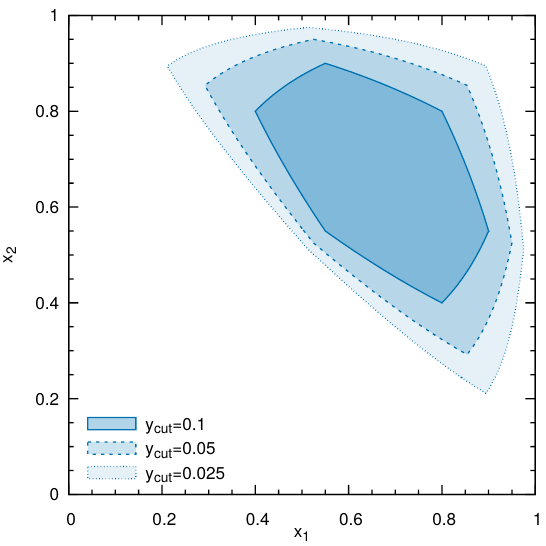
Figure 9 . The Durham algorithm three-jet region for three di(cid:11)erent values of y cut . To obtain the Born three-jet cross section (cid:27) need to integrate the di(cid:11)erential cross section in eq. (B.3) with the constraint y